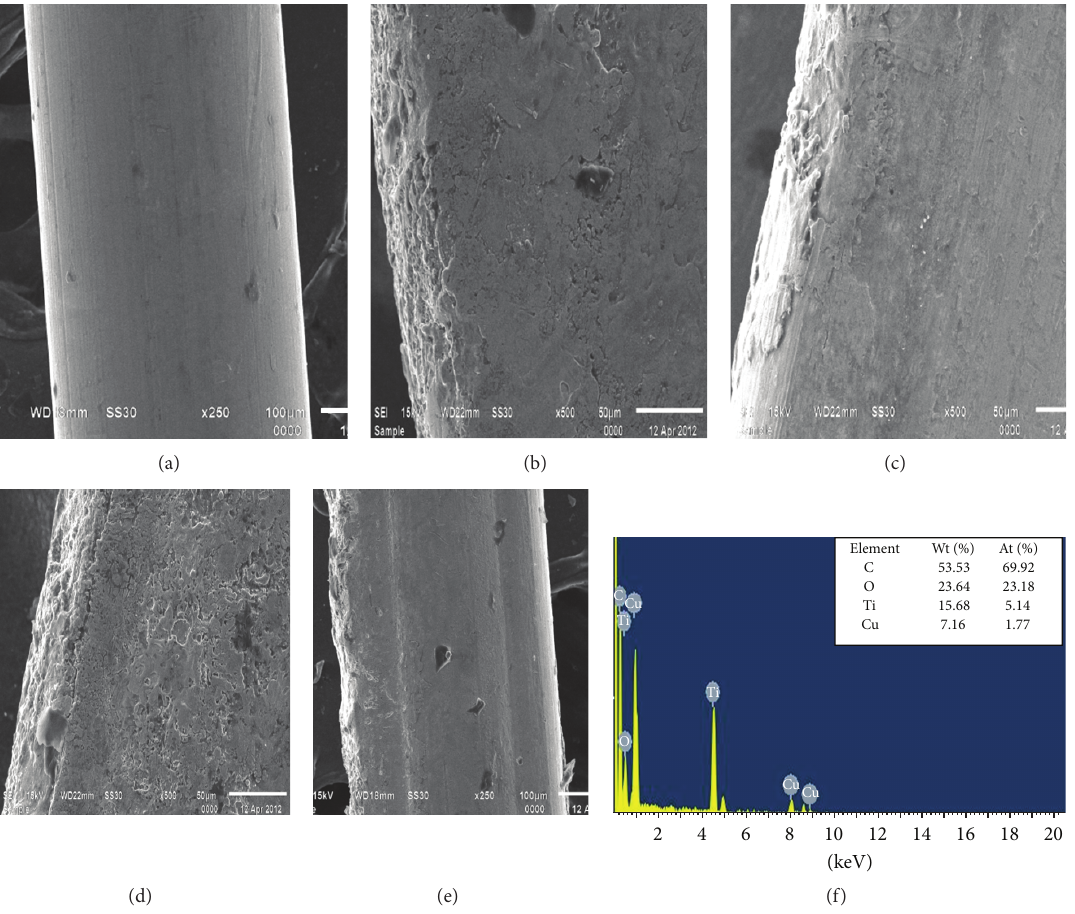
Figure 9: SEM micrographs (250x and 500x) of the machined wire electrode surface for machining of pure titanium at (a) fresh wire; (b) experiment no. 1, at 𝑇 on = 1.1 𝜇 s, 𝑇 off = 28 𝜇 s, Ip = 200A, SV = 50V, WF = 7 m/min, WT = 500 grams; (c) experiment no. 35, at 𝑇 on = 1.1 𝜇 s, 𝜇 s, Ip = 160A, SV = 40 V, WF = 7m/min, WT = 950 grams; ((d),(e)) experiment no. 15, at 𝑇 𝑇 off = 17 50 V, WF = 7m/min, WT = 500 grams; (f) EDX of machined wire electrode at 𝑇 on = 0.9 𝜇 s, 𝑇 off = 38 𝜇 s, Ip = 160A, SV = 50 V, WF = 4m/min, WT = 500 grams.